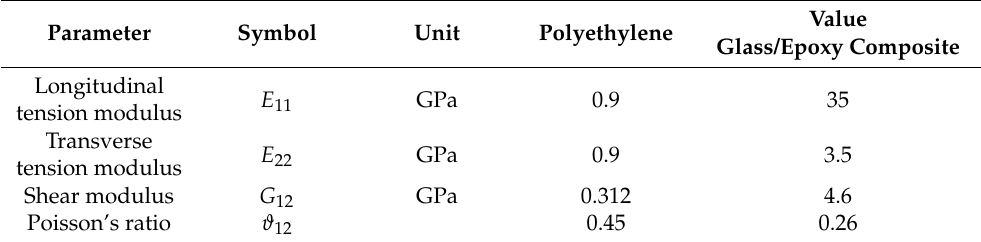
Table 1. Mechanical properties of orthotropic materials [5]. Parameter